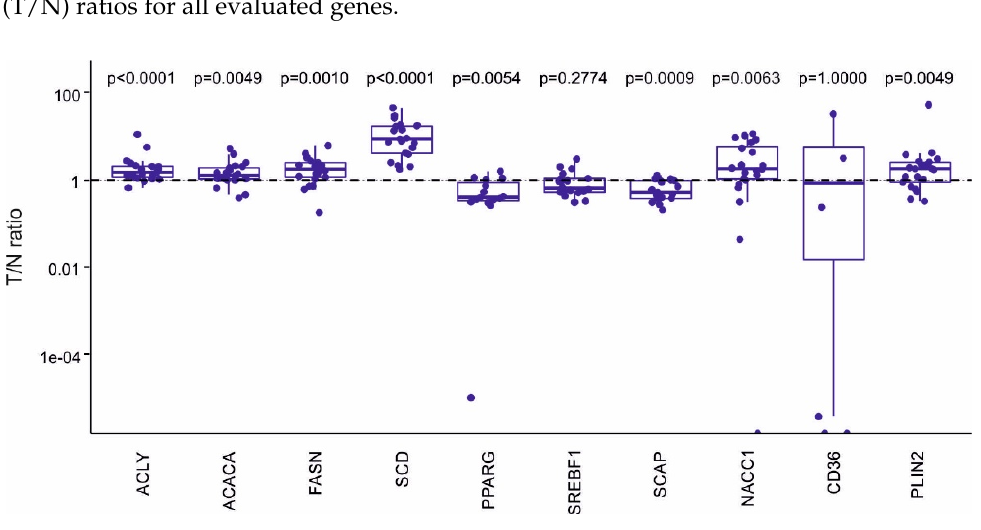
Figure 3. mRNA levels (tumor/non-tumor cell ratio, T/N) of the genes involved in fatty acid (FA) synthesis and control of lipid metabolism. Total RNA samples were isolated from tumor and non-tumor EpCAM + cells, reverse transcribed and then analyzed using custom-made PCR arrays, using IPO8 as a reference gene. Box plots represent data from 22 colon cancer patients. Statistical signifi- cance is indicated above each individual box plot as p -value.